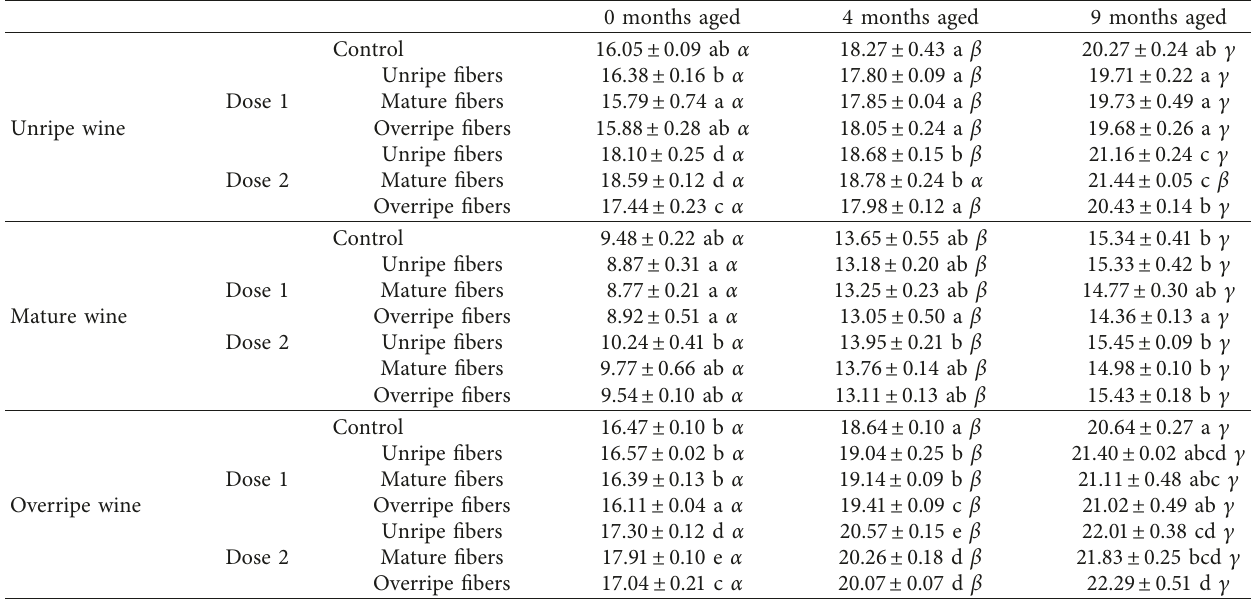
Table 8: Yellowness ( b ∗ ) of the